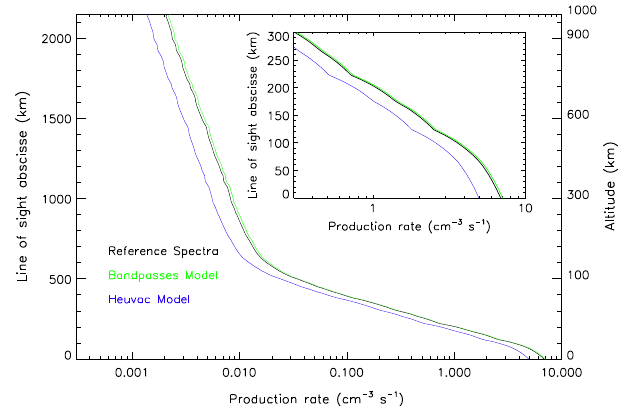
Fig. 3. Electron production rate for three different solar irradiance spectra: the reference spectrum (in black), the one obtained with a bandpass model (in green), and the HEUVAC model (in